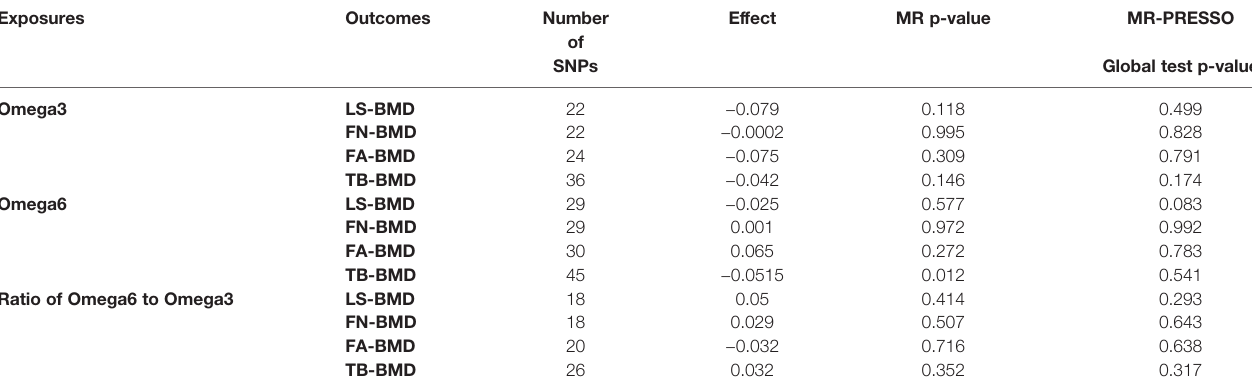
TABLE 2 | MR-PRESSO estimates of the causal effects of PUFAs on